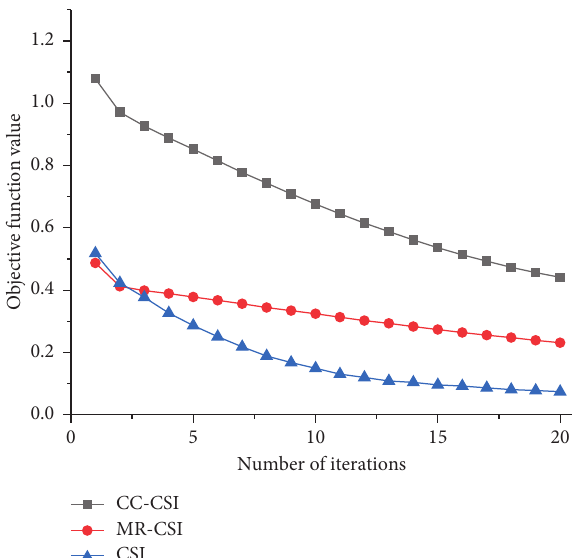
Figure 7: The objective function values of two scatterers (symmetric).